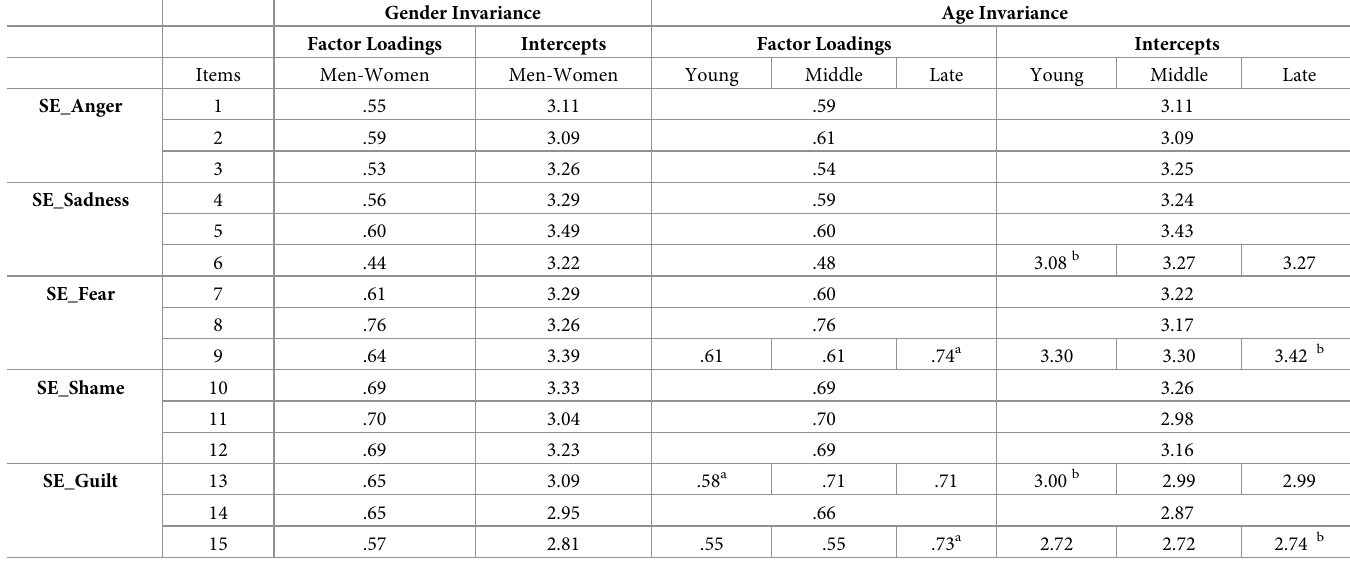
Note. All factor loadings and intercepts were significant at p < .001 a factor loading differed significantly from the other two in the same column under Factor Loadings